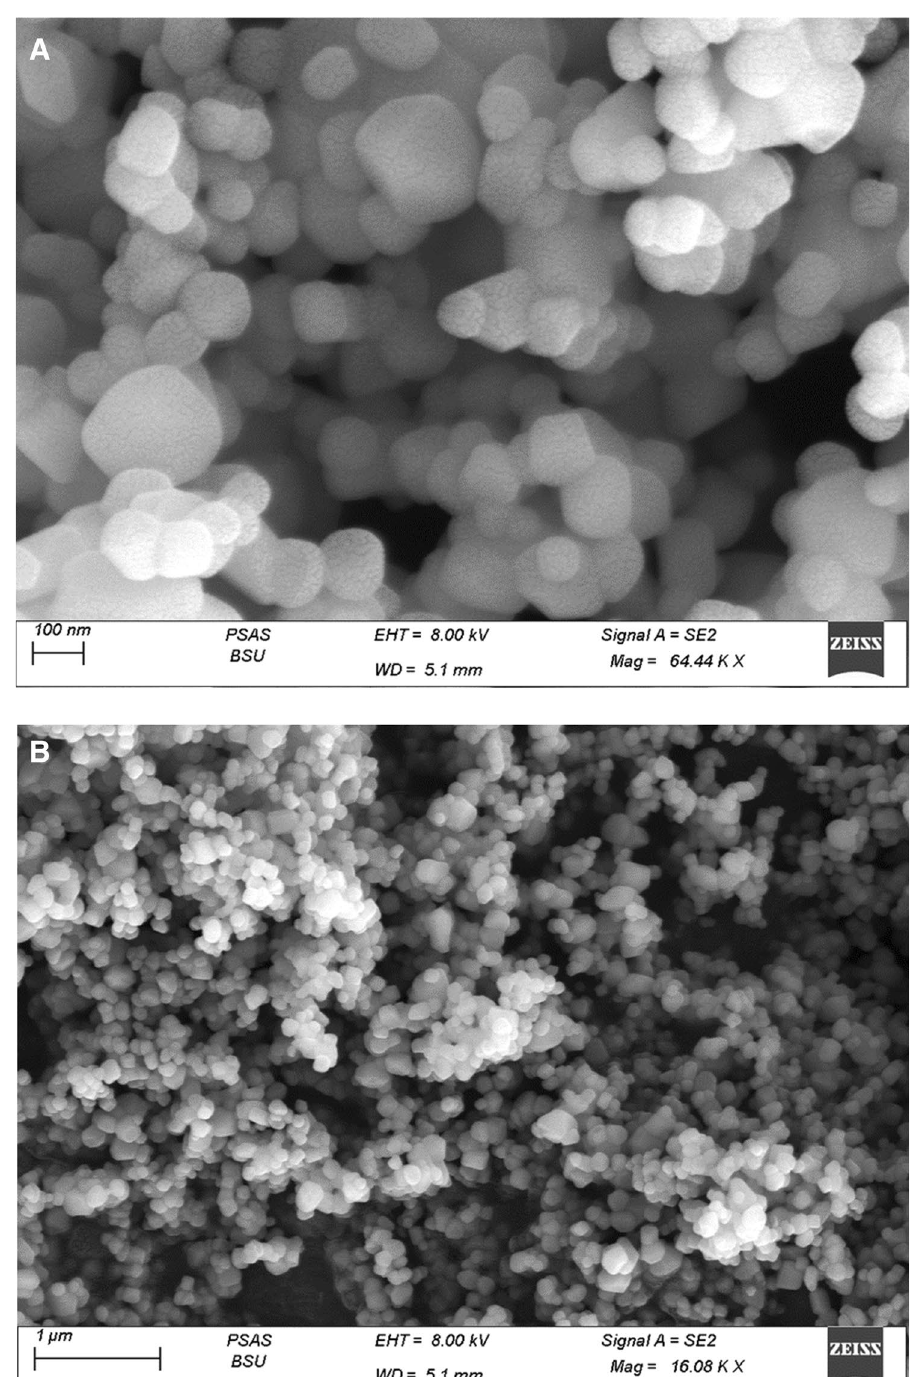
Figure 2. A : HRSEM image of a TiO 2 nanoparticle. B : HRSEM image of a TiO2